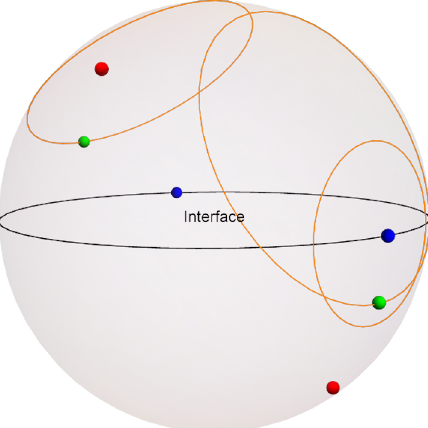
Figure 1 . An example of a defect network in the N = 4 SYM on S 4 that is captured by the 2d dYM on S 2 . In the (cid:12)gure above we have suppressed the two transverse directions to the S 2 YM in S 4 . The black circle at the equator S 1 denotes an interface defect. The orange loops are TQM intersecting Wilson loops. Red dots correspond to bulk local operator insertions, blue dots are local operators on the interface, and green dots are local operators on the Wilson